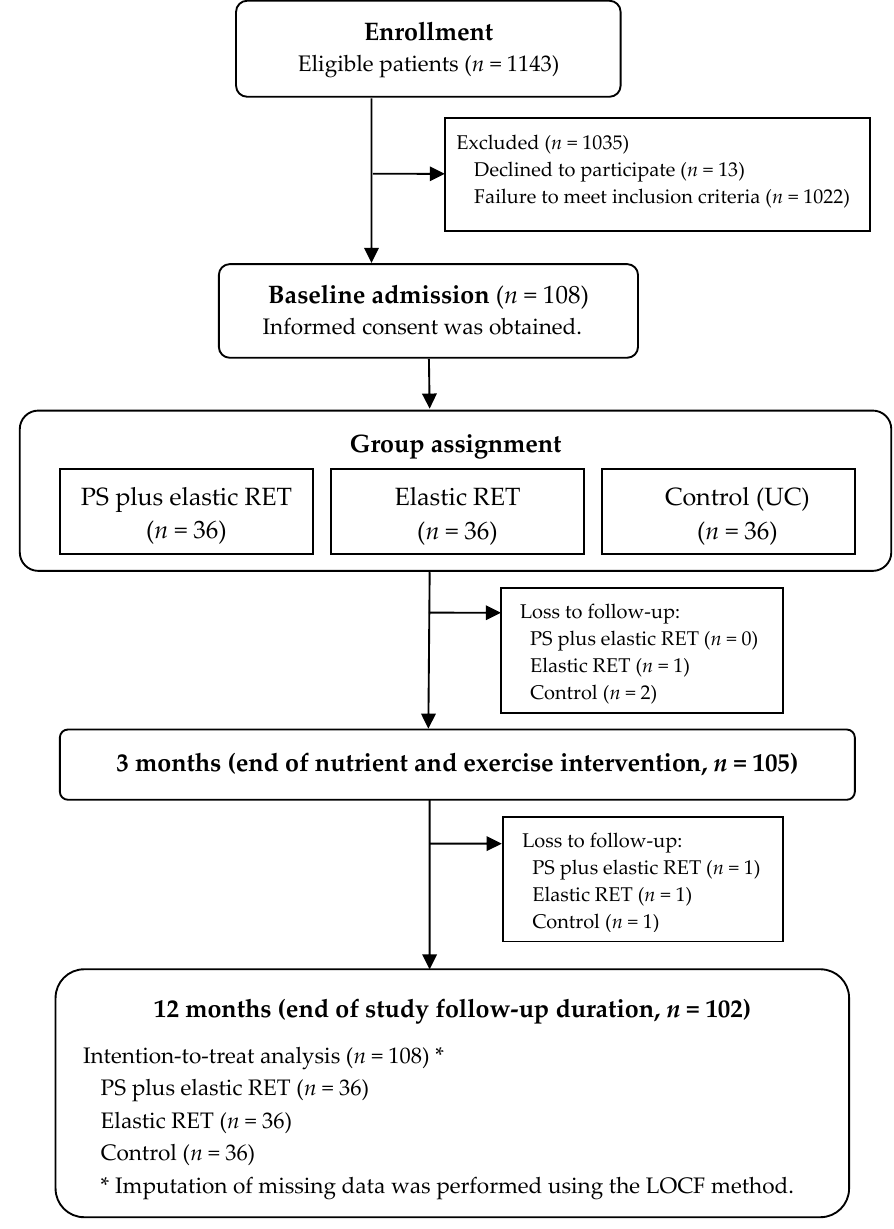
Figure 1. Flowchart of patient enrollment and allocation in the present study. PS, protein supplementation; RET, resistance exercise training; UC, usual care; LOCF, last observation carried forward.